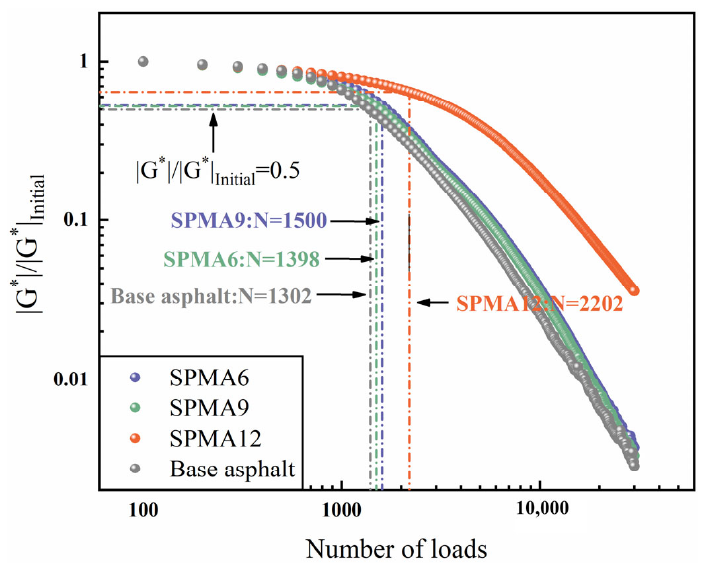
Figure 18. Normalized modulus curve of asphalt binders.